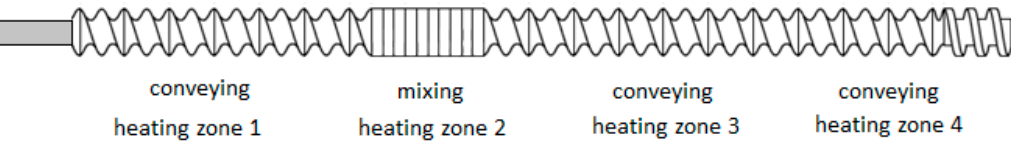
Figure 9. Screw configuration used in the HMI process.